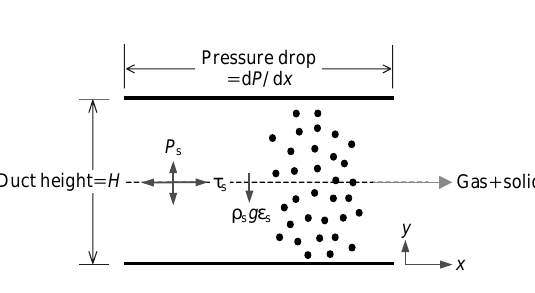
Predicted particle shear stress using Eq. 24 of Tardos et al. (2003). Schematic diagram of the simulation test geometry and